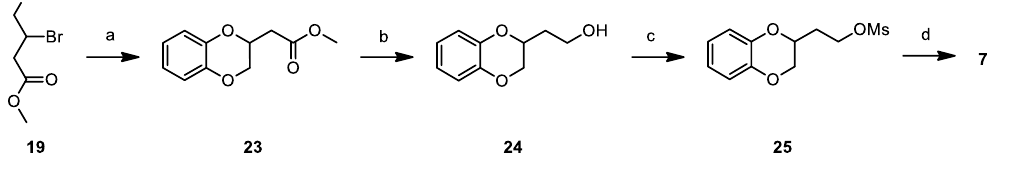
Figure 3. Reaction by-product methyl 4-bromopent-4-enoate.